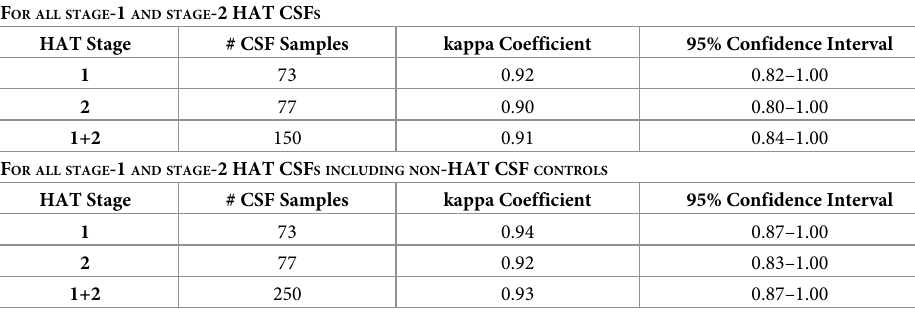
Table 2. Cohen’s kappa test comparing detergent-enhanced RIME versus TBG1 LAMP. F OR ALL STAGE -1 AND STAGE -2 HAT CSF